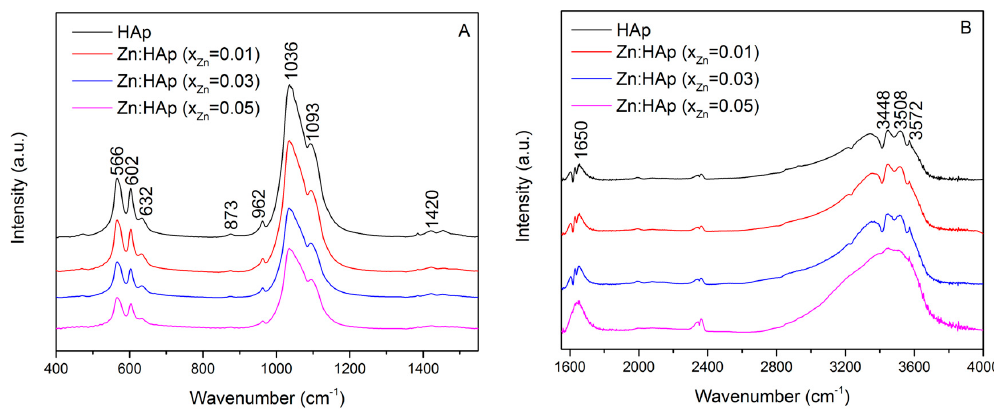
Figure 2. Fourier transform infrared spectroscopy (FTIR) spectra of Zn:HAp, samples with 0 ≤ x Zn ≤ 0.05 from 400 to 1400 cm − 1 ( A ) and from 1600 to 4000 cm − 1 ( B